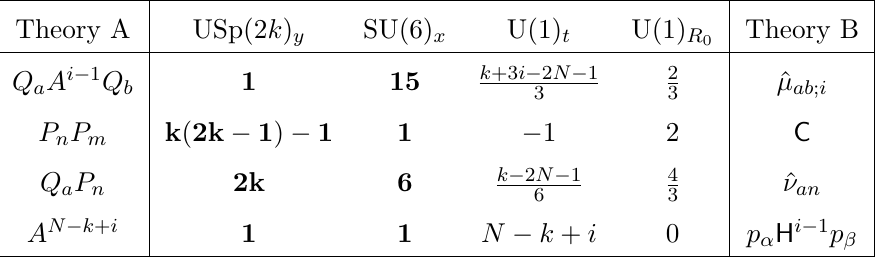
Table 10 . Transformation properties under the global symmetry F A of some of the gauge invariant operators of Theory A and B, from which we can understand how these map under the duality.